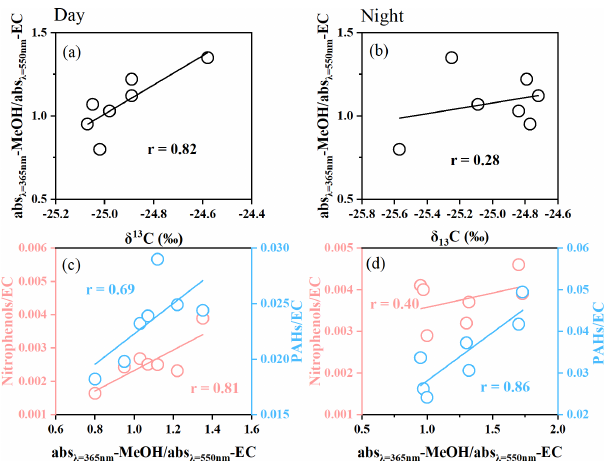
Figure 6. Linear fit regressions for the ratio of light absorp- tion of methanol extracts to light absorption of EC (abs λ = 365nm - MeOH / abs λ = 550nm -EC) with (a, b) δ 13 C and (c, d) the ratio of relative abundance of nitrophenol to EC (nitrophenol / EC) in the daytime and nighttime PM 2 . 5 samples collected during the haze period of 12 to 19 January (corresponding to the cyan shadow in Fig. 5) in